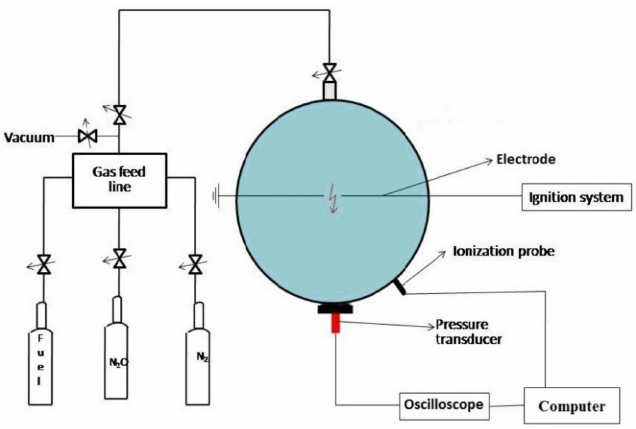
Figure 1. Schematic diagram of the experimental